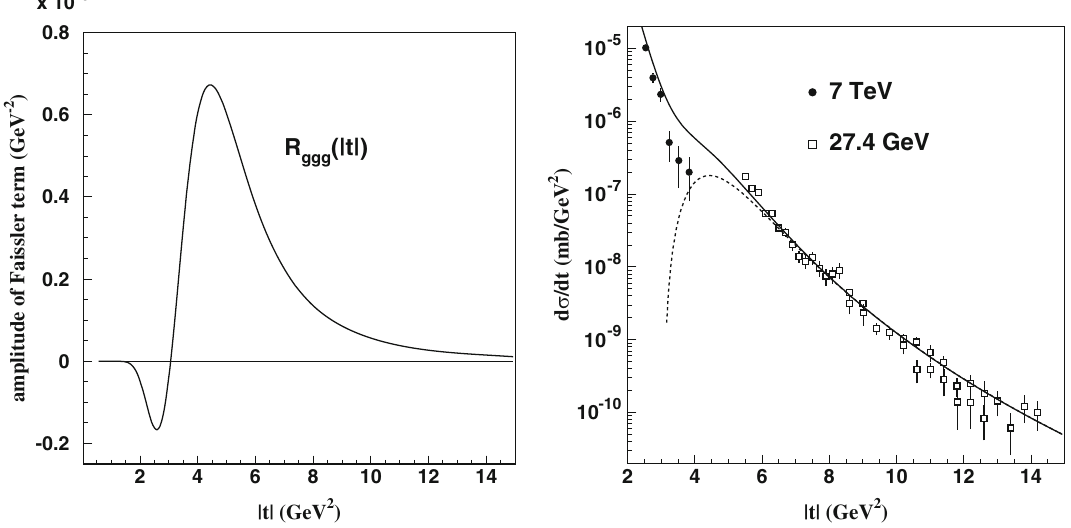
√ s = 27 . 4GeV) points of large Fig. 4 Connection of the low energy ( tion calculated including the R ggg ( | t | ) term (solid line) plotted together | t | (5 . 5 ≤ | t || ≤ 14 . 2 GeV 2 ) with Totem 13 TeV data. a Form pro- with points of Totem measurements at 13 TeV (full circles) and the points (open squares) at 27.4 GeV. The piece of dashed line pointing posed for the amplitude R ggg ( | t | ) in Eq. (18) for three-gluon exchange downwards shows the action of the cut-off factor with a cut-off factor acting for | t | ≤ 4GeV 2 . b Differential cross sec-